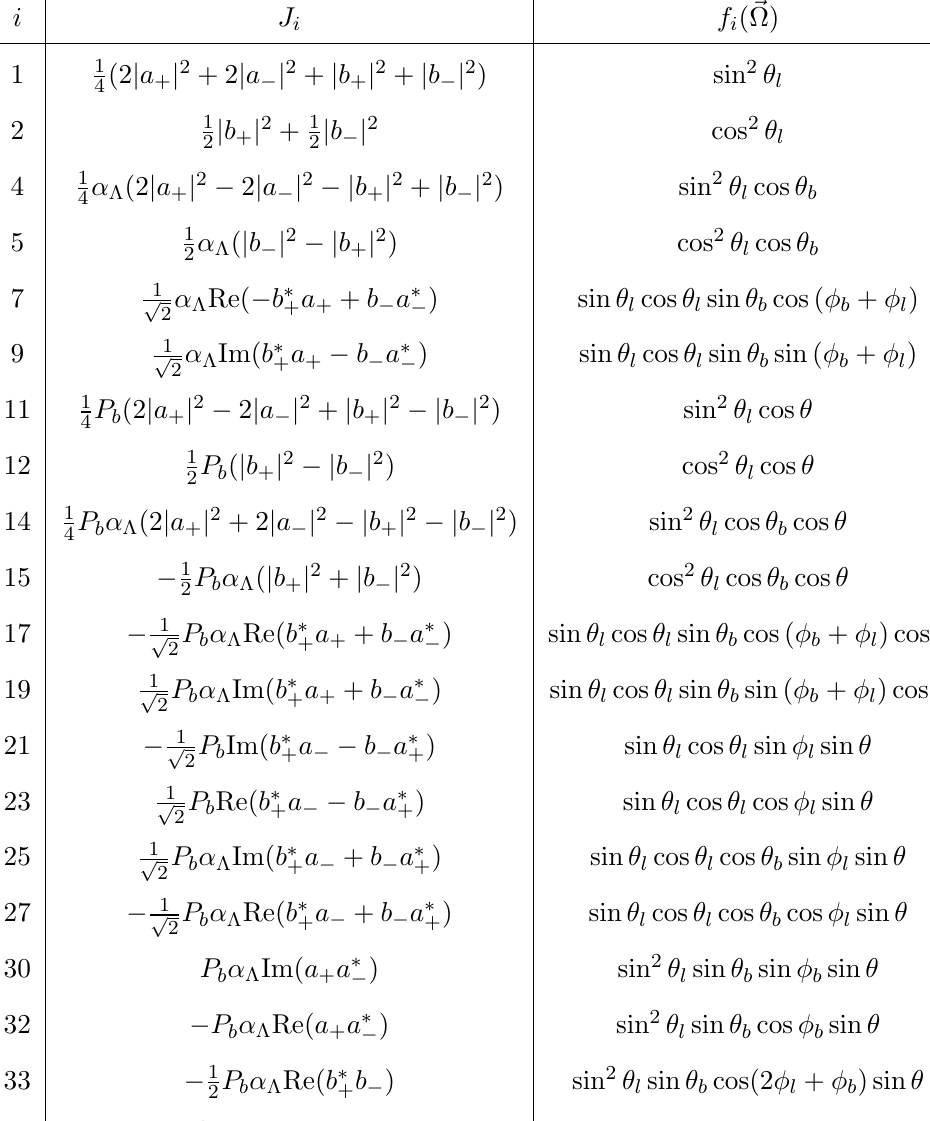
! J= (cid:3) angular distribution. The numbering b